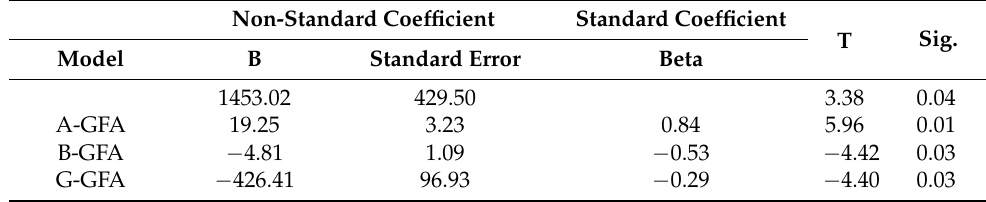
Table 16. Corresponding coefficients.